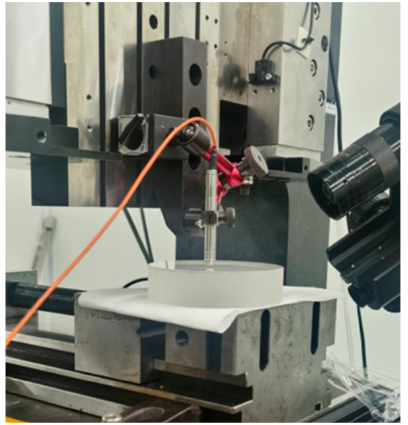
Figure 12. Time-domain vibration measurement in the vertical direction.